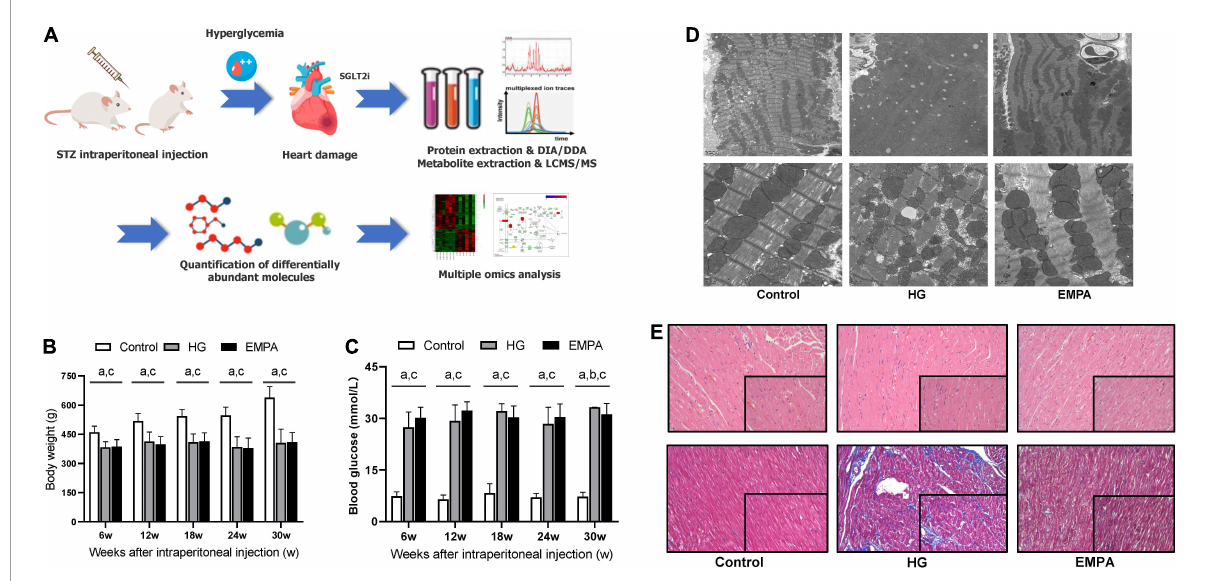
FIGURE1 The study design and phenotypic characteristics of the rats after STZ intraperitoneal injection. (A) Schematic of the study design. (B,C) The body weight (B) and blood glucose (C) of rats in the control, high glucose (HG), and empagliflozin (EMPA) group. (a) comparison is significant for Control vs. HG, (b) comparisons are significant for HG vs. EMPA, and (c) is significant for Control vs. EMPA. (D) Transmission electron microscopy was observed on the rat heart of the three groups. 5,000x (upper part); 20,000x (lower part). (E) Representative photomicrograph of H and E staining (upper part) and Masson’s staining (lower part) of the myocardium, 200x (insert 400x).